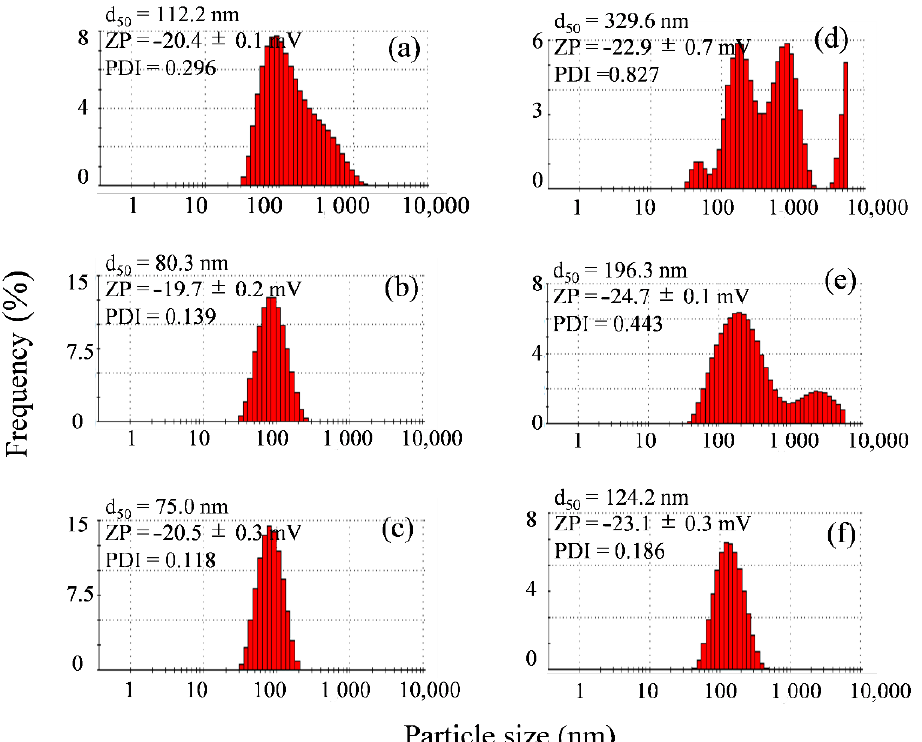
Figure 12. Particle size patterns and zeta potential of Sol/ASC-DP/minoxidil systems at different ratios. ( a ) Sol/ASC-DP/minoxidil = 9/1/1, ( b ) Sol/ASC-DP/minoxidil = 9/1/0.5, ( c ) Sol/ASC-DP/Minoxidil = 9/1/0.25, ( d ) Sol/ASC-DP/minoxidil = 8/2/1, ( e ) Sol/ASC-DP/minoxidil = 8/2/0.5, ( f ) Sol/ASC-DP/minoxidil = 8/2/0.25. Zeta potential: mean ± S.D. ( n = 3).